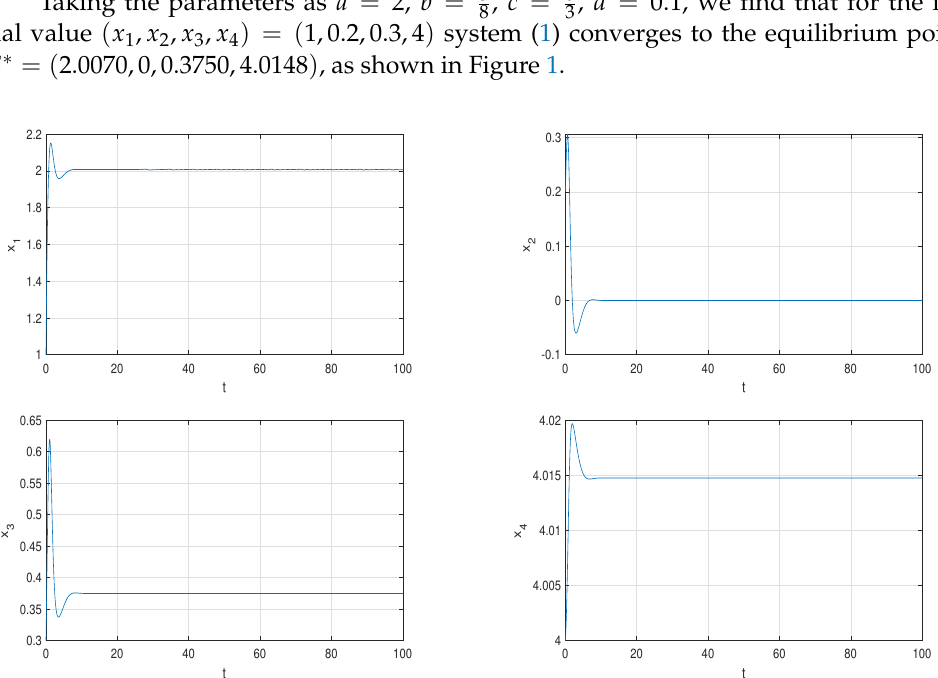
Figure 1. For the initial value ( x 1 , x 2 , x 3 , x 4 ) = ( 1,0.2,0.3,4 ) system (1) converges to the equilibrium point E ∗ = ( 2.0070,0,0.3750,4.0148 )